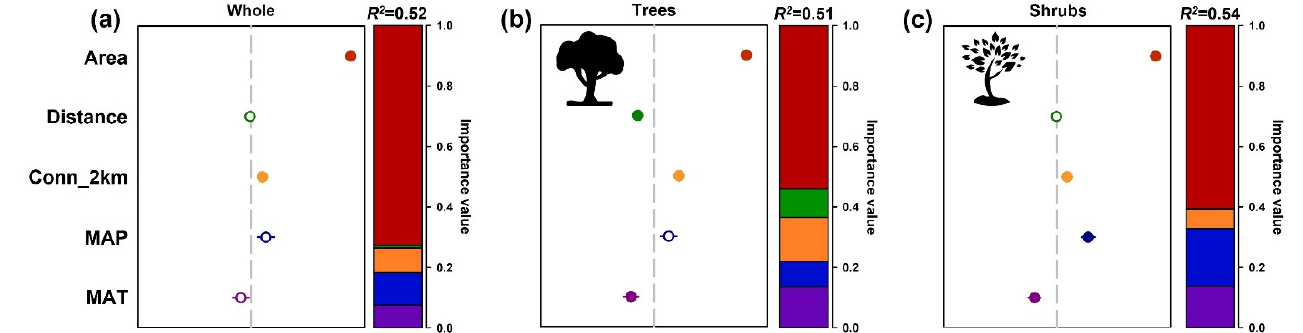
Figure 4. Standardized parameter estimates represent the effects size (circle) with standard error (bar) of five environmental factors for the species richness of ( a ) whole, ( b ) trees, ( c ) shrubs, ( d ) forbs, ( e ) graminoids (sedges, grades, and rushes), and ( f ) ferns in overall islands. The closed and open circles indicate significant and non-significant relationships between species richness and environ- mental factors, respectively. The relative importance of each factor was calculated as the ratio be- tween the parameter estimate of the factor and the sum of all parameter estimates and then de- scribed as a percentage. In the left and right subgraphs of a graph, the same color represents the same variable. Abbreviations for the factors are shown in Figure 3. 3.3. Species Richness Patterns of Plant Growth Forms with Environmental Variables between Inhabited and Uninhabited Islands The simple OLS results revealed that on the inhabited islands, distance from the mainland and structural connectivity showed no relationships for all growth forms (Fig- ure 5 and Table S8). The MAT showed a negative relationship in all growth forms except shrubs and ferns, whereas MAP showed no relationships in all growth forms apart from shrubs and ferns. In the results of the model averaging approach, island area (positive effect), MAP (positive effect), and MAT (negative effect) had significant effects for whole plants, trees, and forbs (Figure 6 and Table S9). For shrubs and ferns, island area (positive effect), distance from the mainland (positive effect), MAP (positive effect), and MAT (neg- ative effect) had significant effects. Graminoids showed a significant positive relationship only with island area. On uninhabited islands, trees and shrubs showed negative relation- ships with the distance from the mainland (Figure 5 and Table S10). Structural connectiv- ity had positive relationships with shrubs, trees, and ferns. The MAT showed negative and positive relationships with trees and ferns, respectively. In the results of the model averaging approach, MAP showed no relationships in all growth forms except ferns (Fig- ure 7 and Table S11). Island area was positively correlated with species richness for whole plants, forbs, and graminoids. For shrubs and trees, island area (positive effect), distance from the mainland (negative effect), and structural connectivity (positive effect) were sig- nificant variables. Island area (positive effect) and MAP (positive effect) were important predictors for fern species.